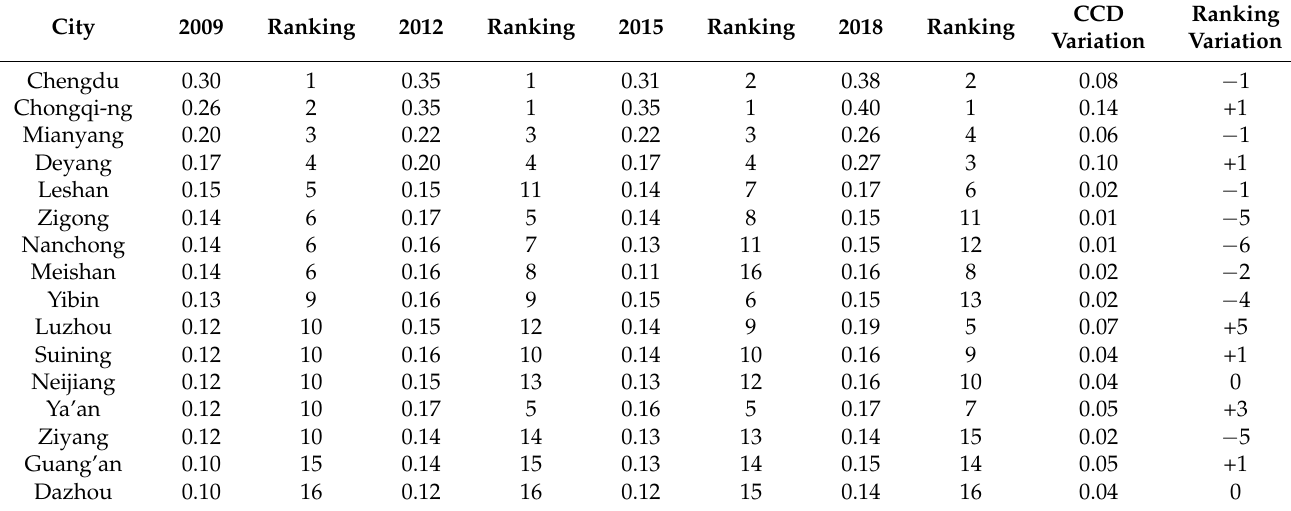
Table 3. Variation of the